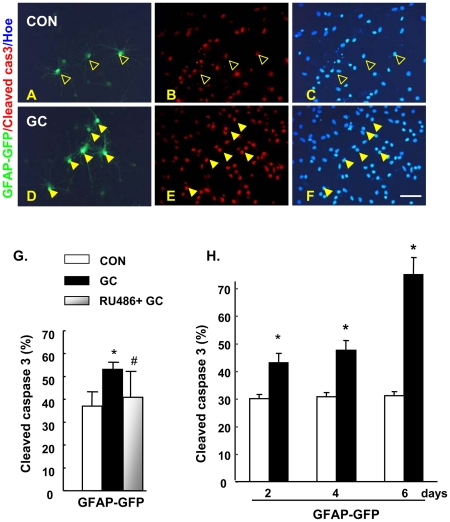
Caspase 3 is activated by GC-treated in astrocytes grown in mixed hippocampal cultures.As compared to vehicle-treated GFAP-GFP-labeled astrocytes (A–C), those treated with GC (D–F) displayed moderate levels of activated caspase 3. Open arrowheads indicate GFAP-GFP+/cleaved caspase 3− staining; solid arrowheads indicate GFAP-GFP+/cleaved caspase 3+ cells. The GR antagonist RU38486 significantly attenuated GC-stimulated activation of caspase 3 (G). Extended exposure of cultures to GC (48–144 h) led to a progressive increase in activated caspase 3 immunoreactivity in GFAP-GFP tagged astrocytes (H), without causing significant apoptosis monitored by TUNEL and Hoechst staining (not shown). All numerical data represent mean ± SD. * p<0.05 vs. CON, # p<0.05 vs. GC. Scale bar: 50 µm.